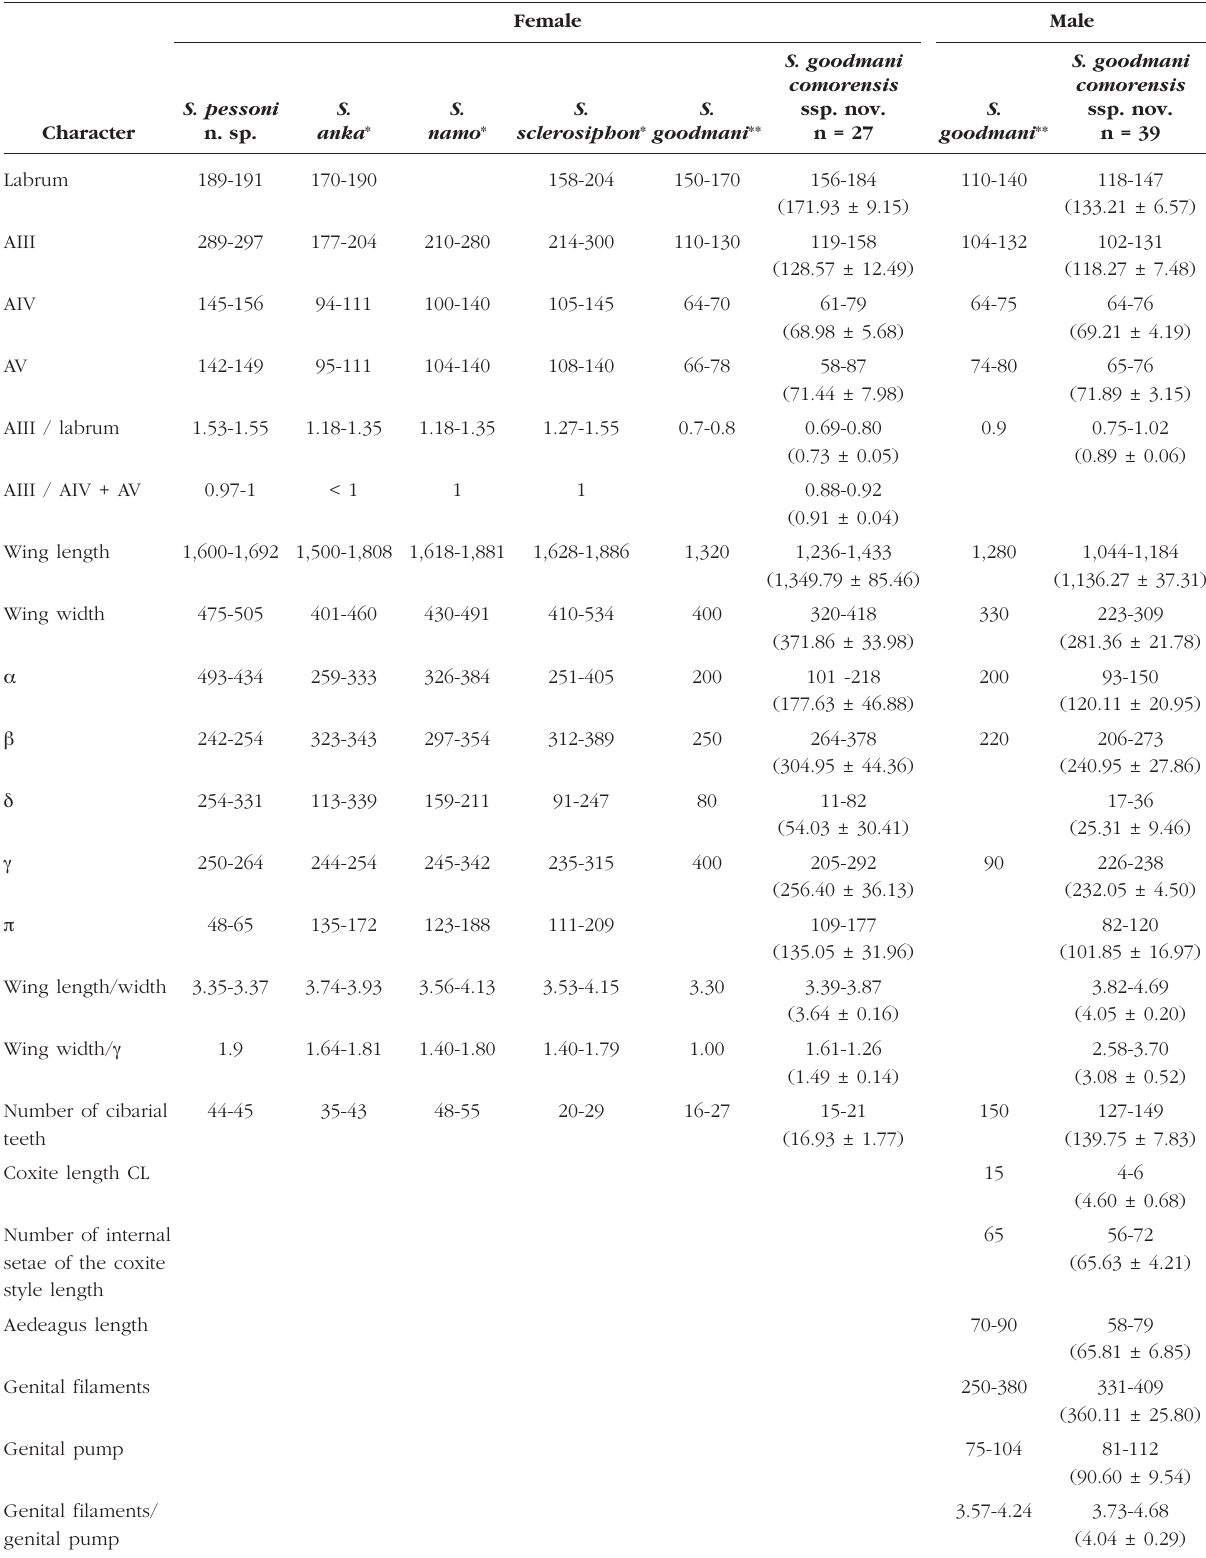
Table II. – Descriptive statistics related to morphometry; for each